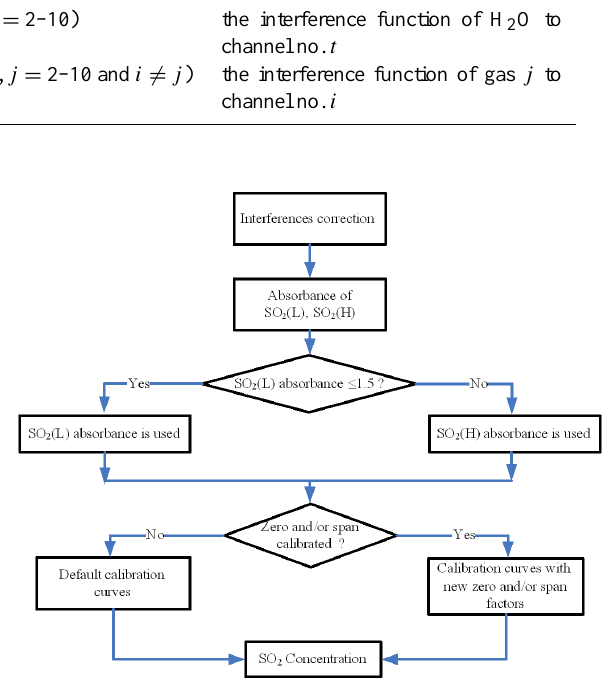
Figure 4. Flowchart of SO 2 concentration retrieval. The retrieval channel is chosen based on the interference-corrected absorbance of SO 2 (L). See text for further